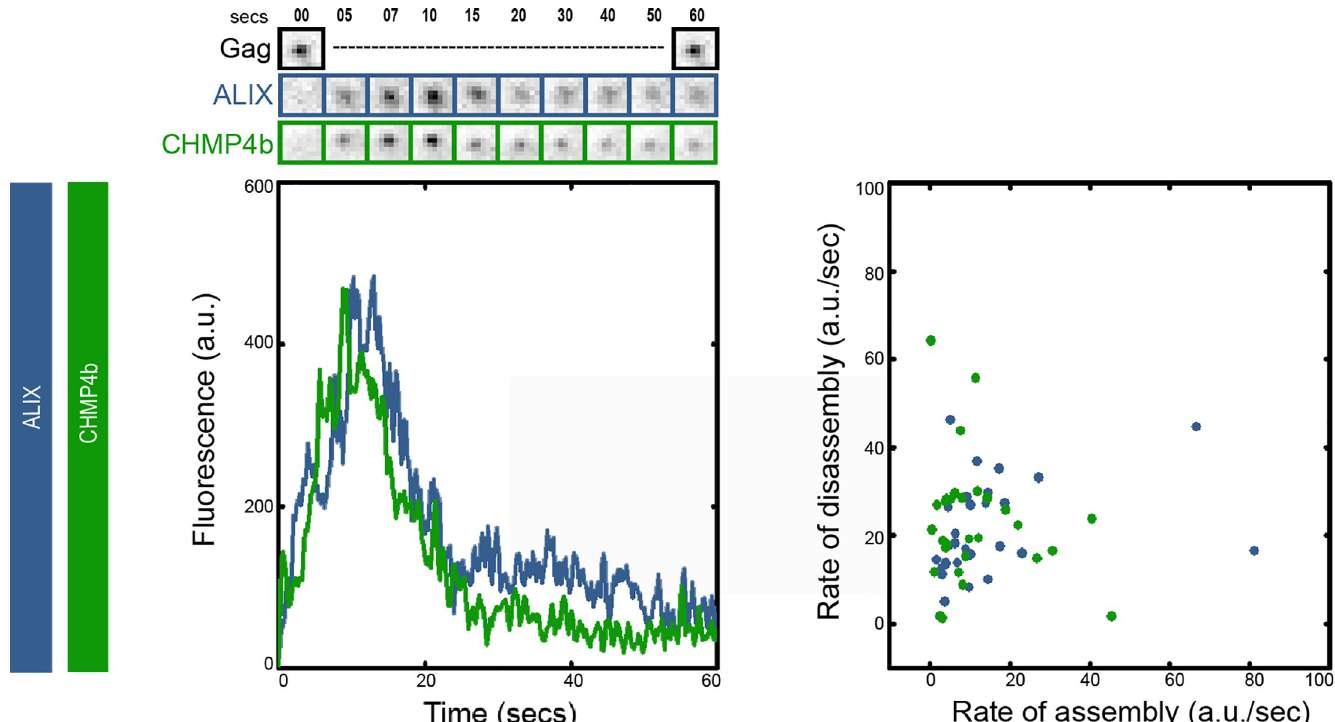
Fig 3. ALIX and CHMP4b assemble and disassemble together. The left graph shows the intensity plot of ALIX (Blue) and CHMP4b (Green) and cropped TIRF images of the Gag (topmost, Black), ALIX (middle, Blue) and CHMP4b (bottom, Green). The scatter plot on the right shows the rate of assembly and disassembly for ALIX and CHMP4b. (Rates of assembly/disassembly are defined in S2 Fig).